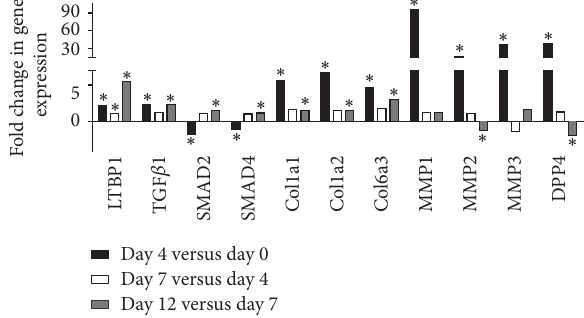
Figure 4: Fold changes in expression of genes related to adipogenic and lipogenic functions during the dedifferentiation process ( ∗ 𝑃 ≤ 0.05 ).